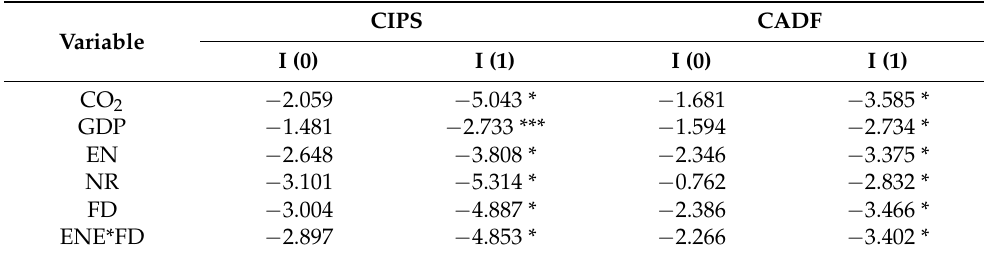
Table 3. Unit root test